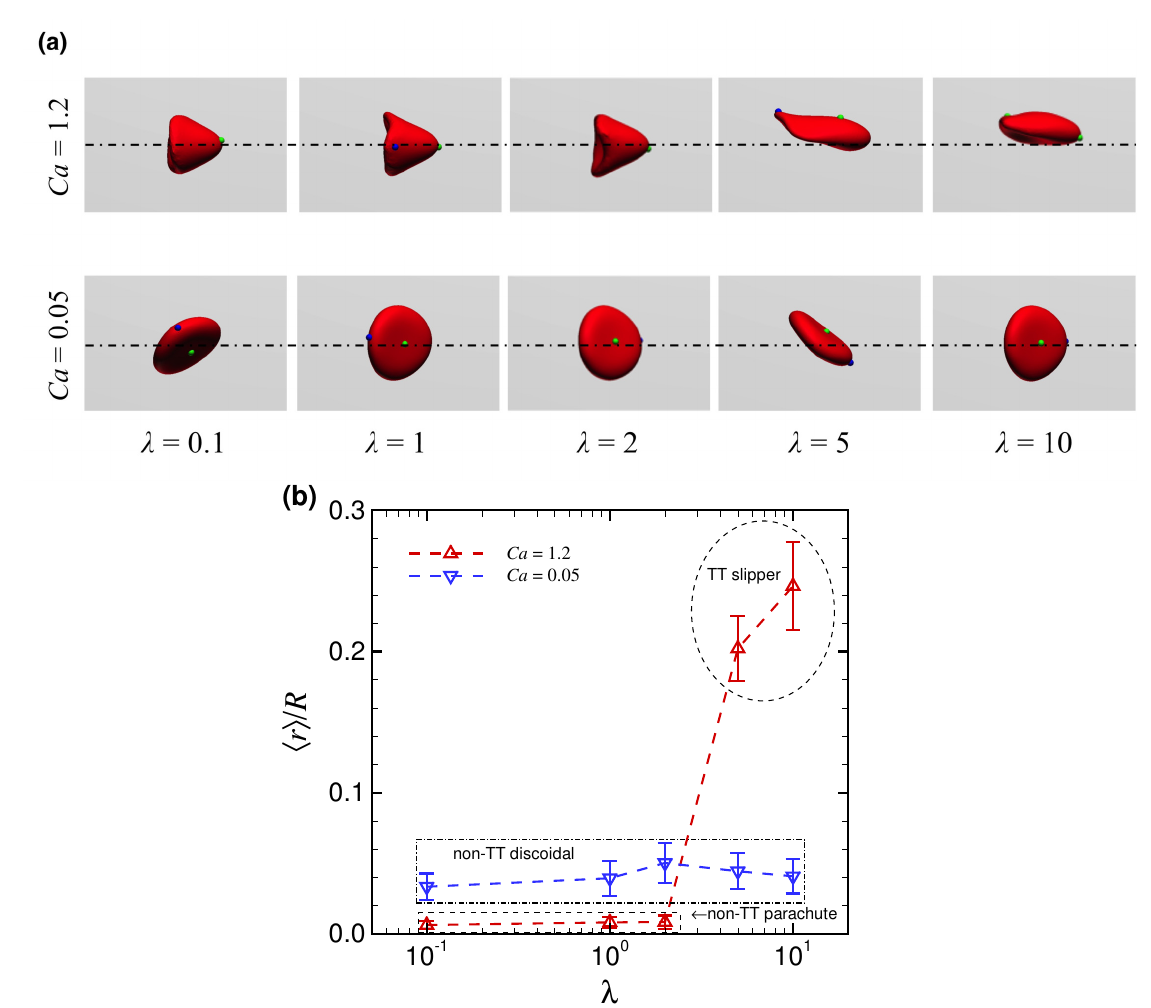
Figure 5. ( a ) Snapshots of flowing RBCs in steady state at Ca = 0.05 (bottom row) and Ca = 1.2 (top row) for different λ . ( b ) Time average of the radial position of the RBC centroid Ca = 1.2 (red triangles). The results were obtained with an initial off-centered position at r 0 / R =